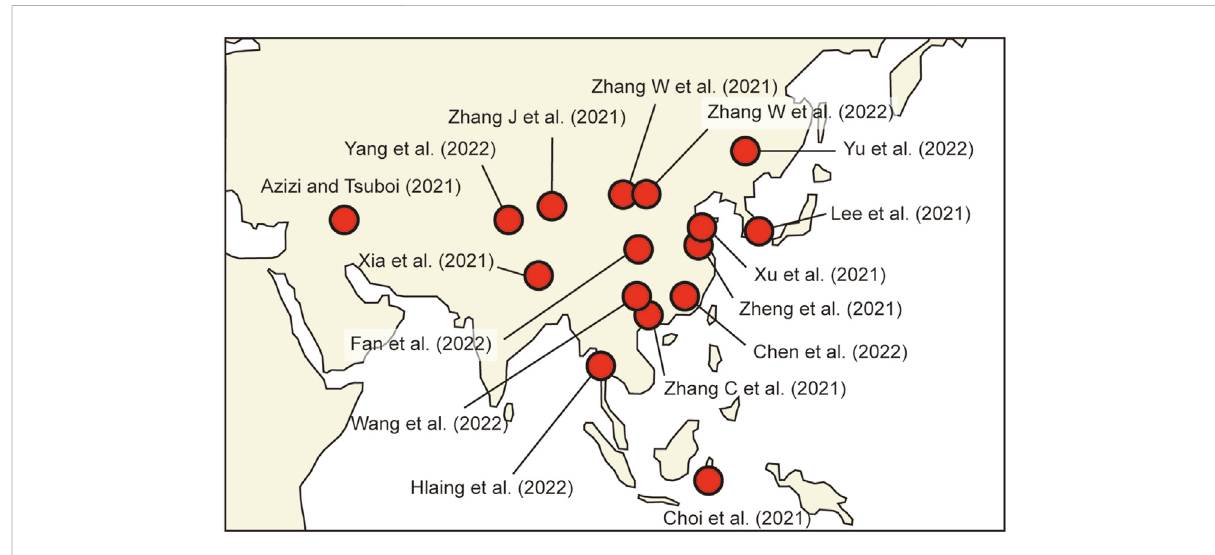
Geographic map of East and Central Asia, showing the study area of the 16 papers in this Research